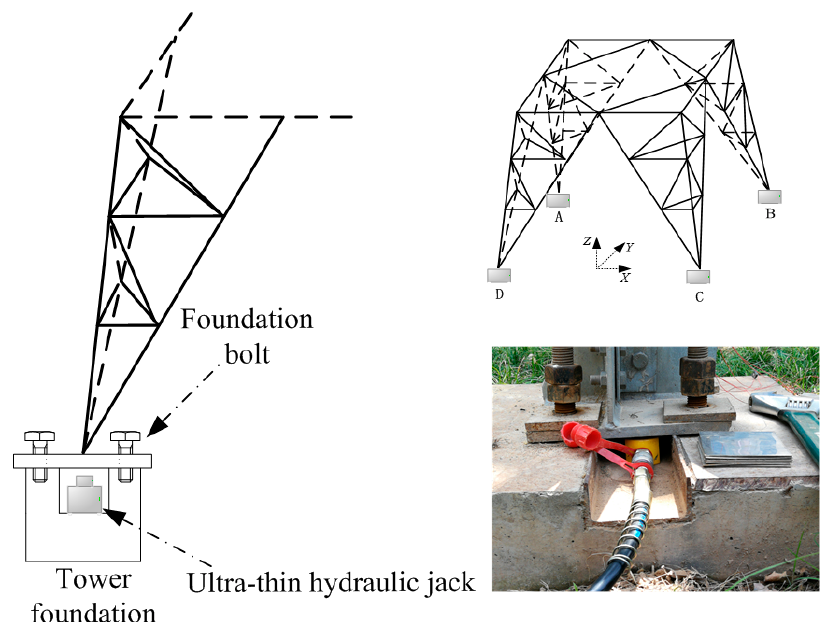
Figure 8. Tower foundation settlement experiment platform.